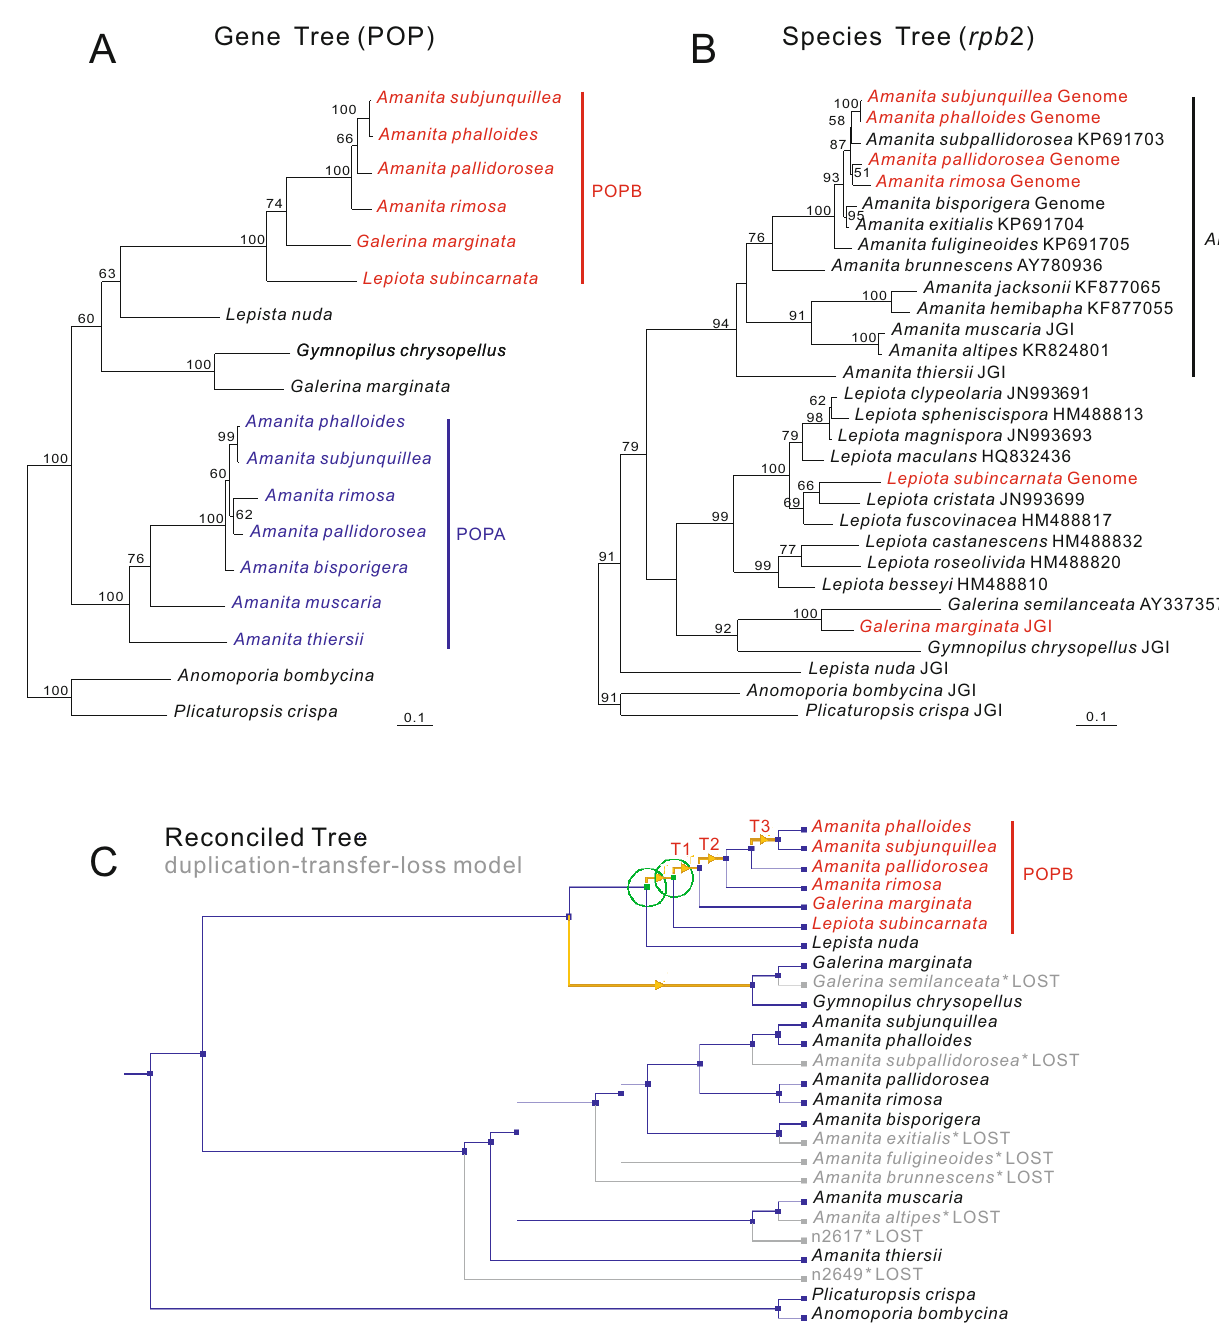
Fig. 6. Comparison of POP gene tree and species tree. A. POP (cid:2)(cid:25)(cid:13)(cid:17)(cid:13)(cid:2)(cid:8)(cid:10)(cid:13)(cid:13)(cid:28)(cid:2)(cid:135)q(cid:135).(cid:2)(cid:23)(cid:11)(cid:17)(cid:13)(cid:9)(cid:25)(cid:13)(cid:2)(cid:15)(cid:9)(cid:7)(cid:2)(cid:14)(cid:11)(cid:25)(cid:14)(cid:23)(cid:11)(cid:25)(cid:14)(cid:8)(cid:13)(cid:21)(cid:2)(cid:11)(cid:17)(cid:2)(cid:10)(cid:13)(cid:21)W(cid:2)(cid:135)q(cid:135)$(cid:2)(cid:23)(cid:11)(cid:17)(cid:13)(cid:9)(cid:25)(cid:13)(cid:2)(cid:11)(cid:17)(cid:2)(cid:12)(cid:23)(cid:5)(cid:13)(cid:28)(cid:2) B. Species tree based on rpb2 . Corresponding species for the POPB lineage were highlighted in red. Amanita lineage was indicated by a black bar. The transfer events in the strongly supported POPB lineage were marked as T1, T2 and